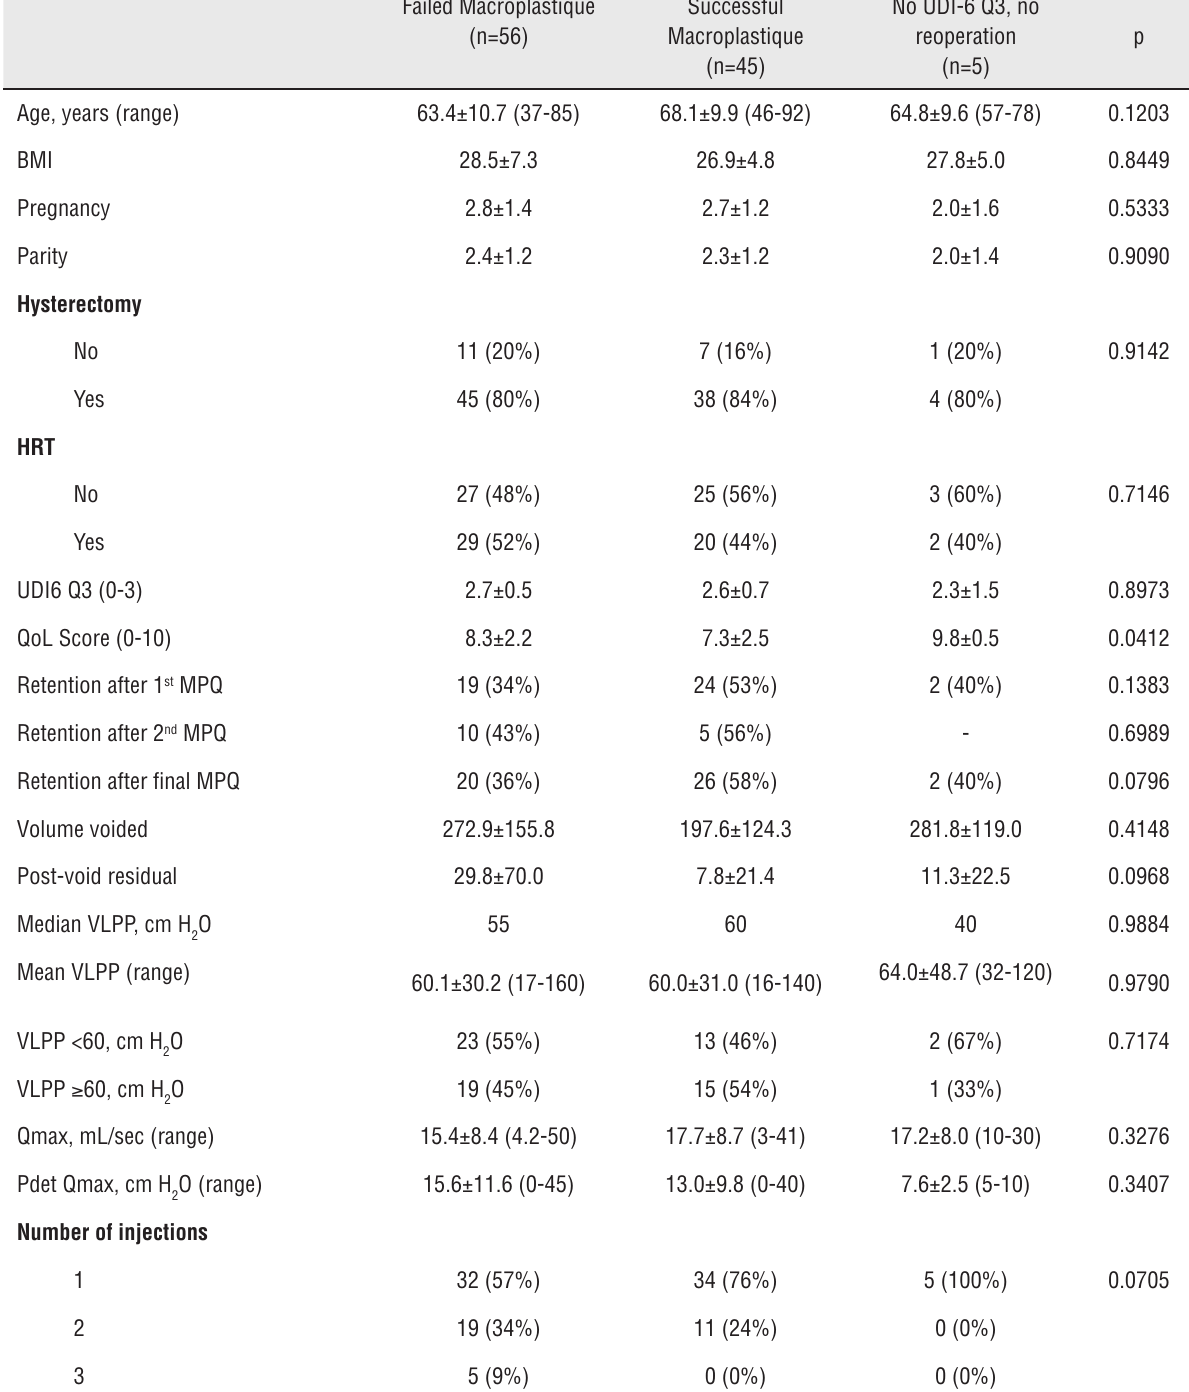
Table 2 - Patient characteristics by success after final Macroplastique. Failed